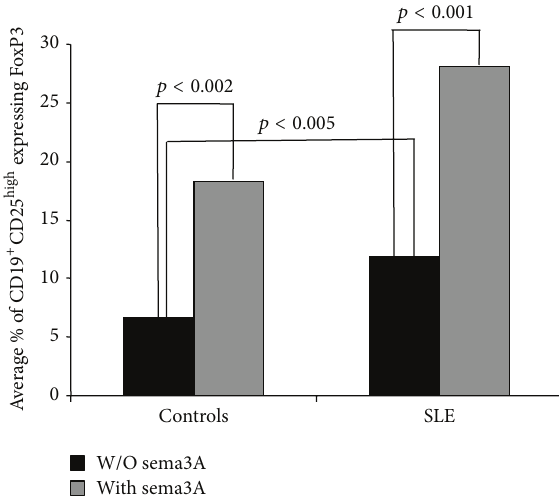
Figure 3: The percentage of CD 19 + CD 25 high FoxP 3 high Breg cells in normal controls ( 𝑛 = 20 ) and in patients suffering from SLE ( 𝑛 = 21 ). One can see that this subtype of B cells is significantly increased in SLE patients. In addition, the addition of sema3A to these cells increased significantly the percentage of these cells.